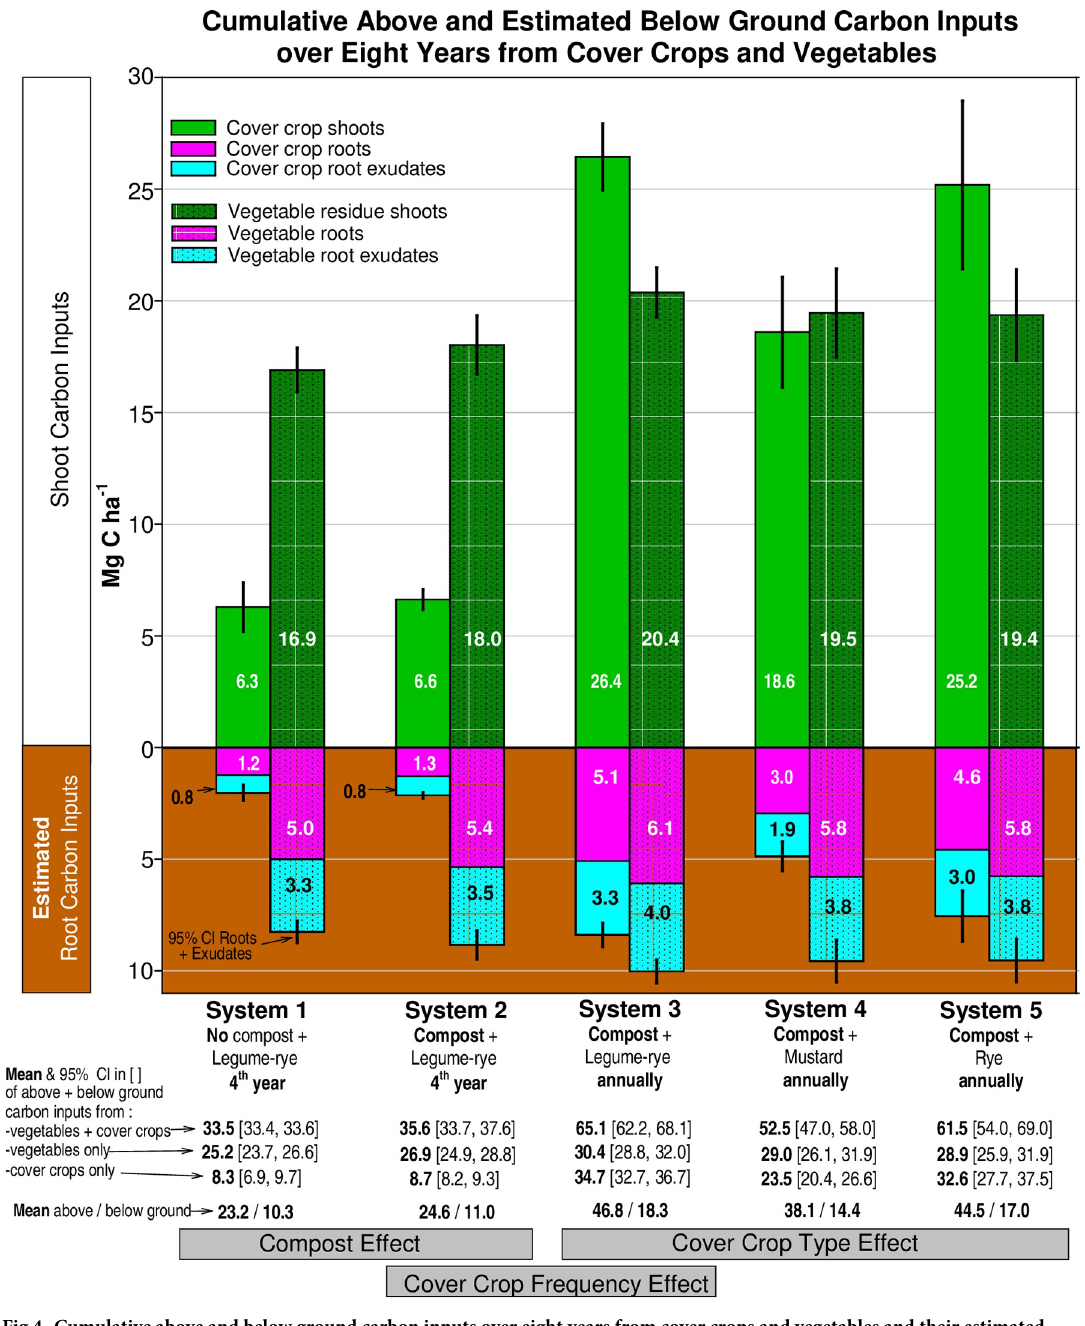
Fig 4. Cumulative above and below ground carbon inputs over eight years from cover crops and vegetables and their estimated below ground inputs from roots and root exudates during 8 years in five organic vegetable systems in Salinas, CA. Systems differed by annual compost additions (0 vs. 7.6 Mg ha-1 before each vegetable crop), cover crop type (legume-rye, mustard or cereal rye alone) and cover cropping frequency (quadrennially vs. annually planted). The grey boxes indicate the systems to compare to evaluate the effects of compost, cover crop frequency, and cover crop type. Error bars are 95% confidence intervals (CI) for shoots, and roots + root exudates. Due to rounding, the sum of the values within the bars for each system may differ slightly from the mean value shown below each system. The assumptions used to estimate the below ground inputs are described in the Materials and